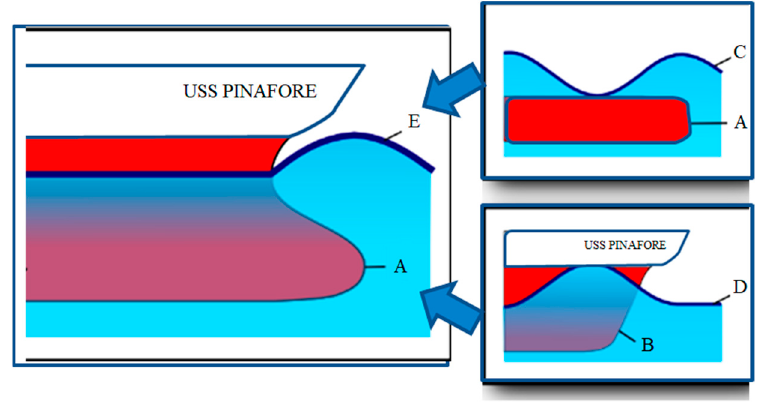
Figure 3. Bulb wave interference principle ( A ) bulb; ( B ) bow; ( C ) bulb wave; ( D ) bow wave; ( E ) combined wave = bow wave − bulb wave.